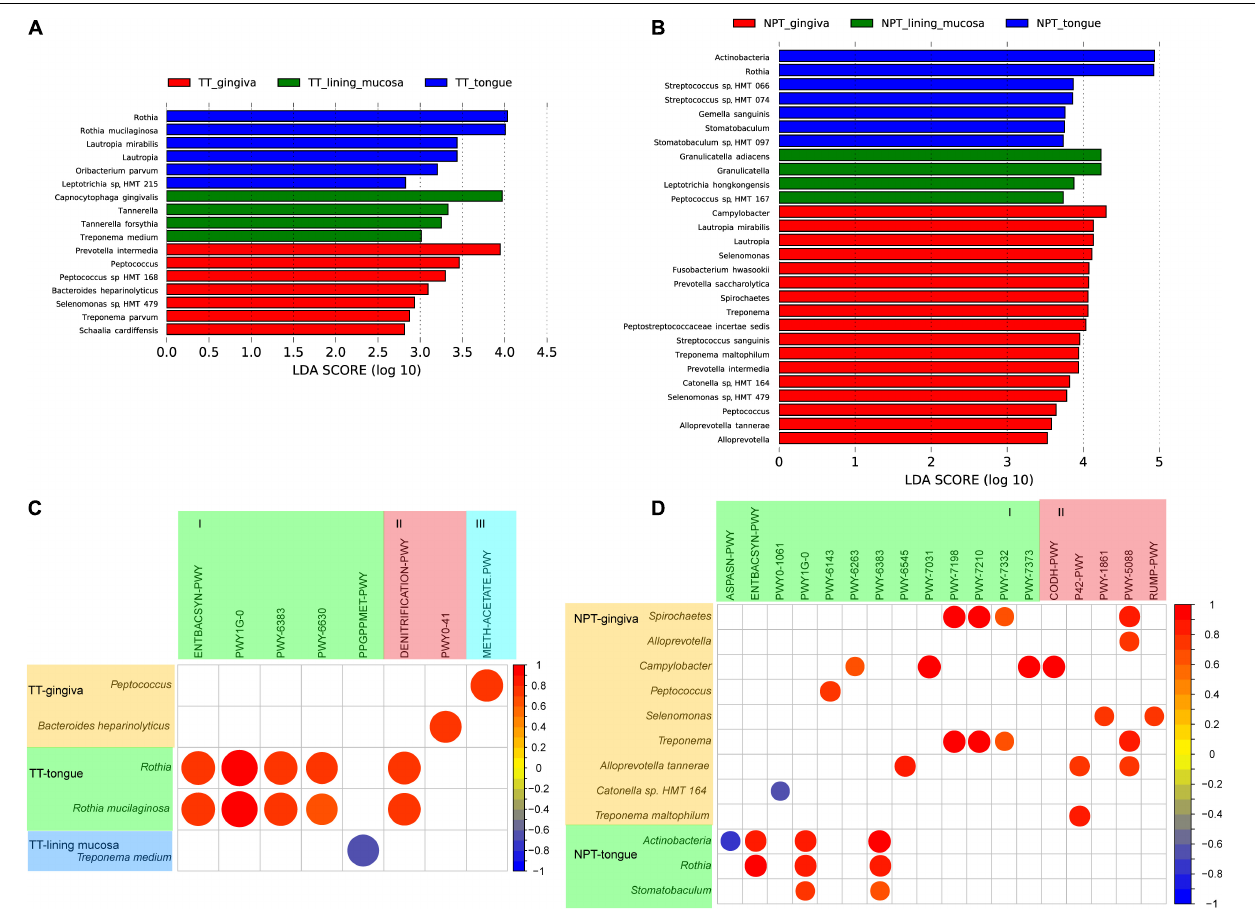
FIGURE 6 | Comparative taxonomic profile and association with pathways of different tumor sites of OSCC. (A) LDA scores computed for differentially abundant taxa of TT among the tumor sites (Log10 LDA scores > 2). (B) LDA scores computed for differentially abundant taxa of NPT among the tumor sites (Log10 LDA scores > 2). (C) Correlation coefficient among different taxa and minipaths of TT samples among the different tumor sites. (D) Correlation coefficient among different taxa and minipaths of NPT samples among the different tumor sites. I, biosynthesis; II, degradation/utilization/assimilation; III, generation of precursor metabolites and